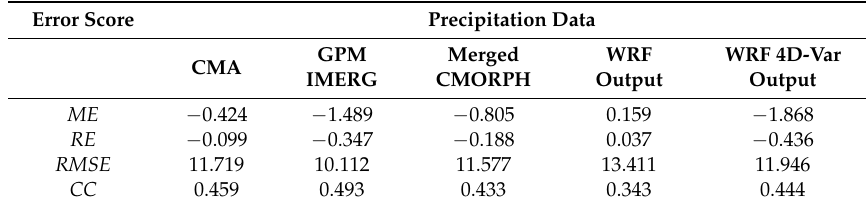
Table 6. Error scores of mean error ( ME ), relative error ( RE ), root mean square error ( RMSE ) and Pearson’s correlation coefficient ( CC ) for the point-scale precipitation evaluations between the daily CMWR data and the daily grid data with 1-km resolution from different precipitation data.